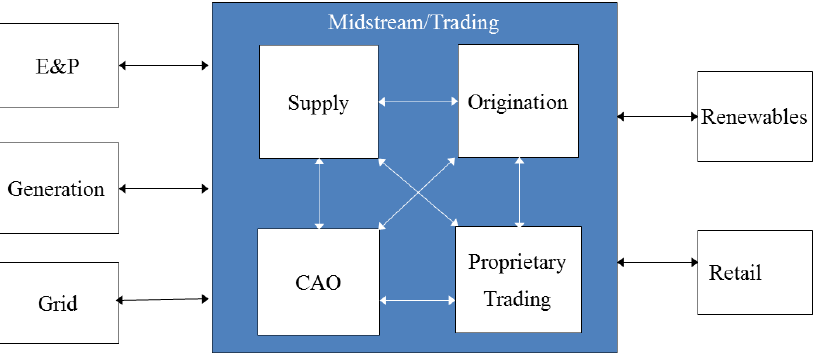
Figure 13. Overview of the main cross-functional synergies between the asset classes of the stage “trading” and the other asset classes (supra-regional). Own illustration, based on RWE internal information.